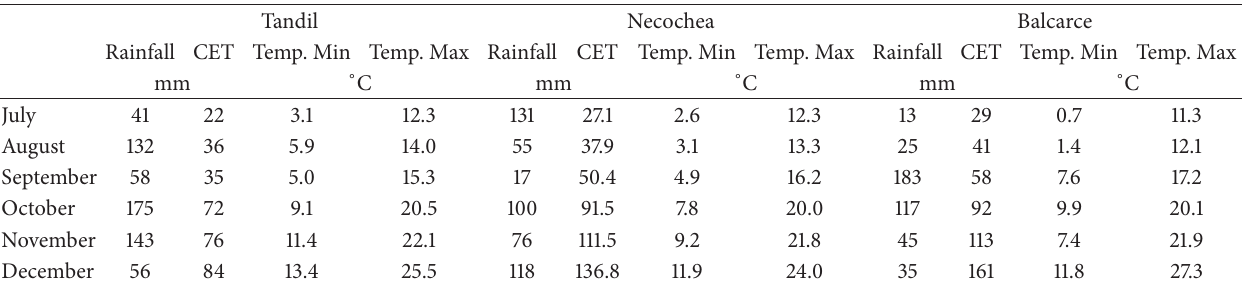
Table 2: Monthly rainfall (mm), mean minimum temperature ( ∘ C), mean maximum temperature ( ∘ C), and crop evapotranspiration (CET) during wheat growing season at Tandil, Necochea, and Balcarce experimental sites. Tandil Necochea